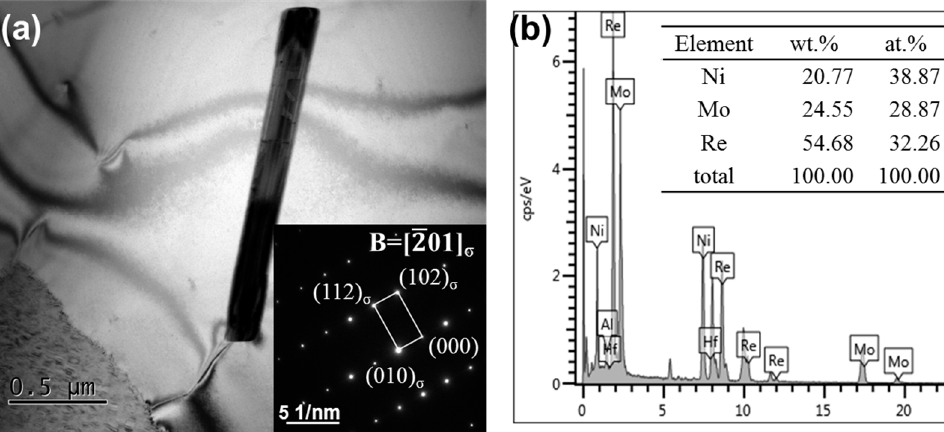
Figure 10. Area fraction ( a ) and length ( b ) of TCP phases of samples after different thermal exposure times.